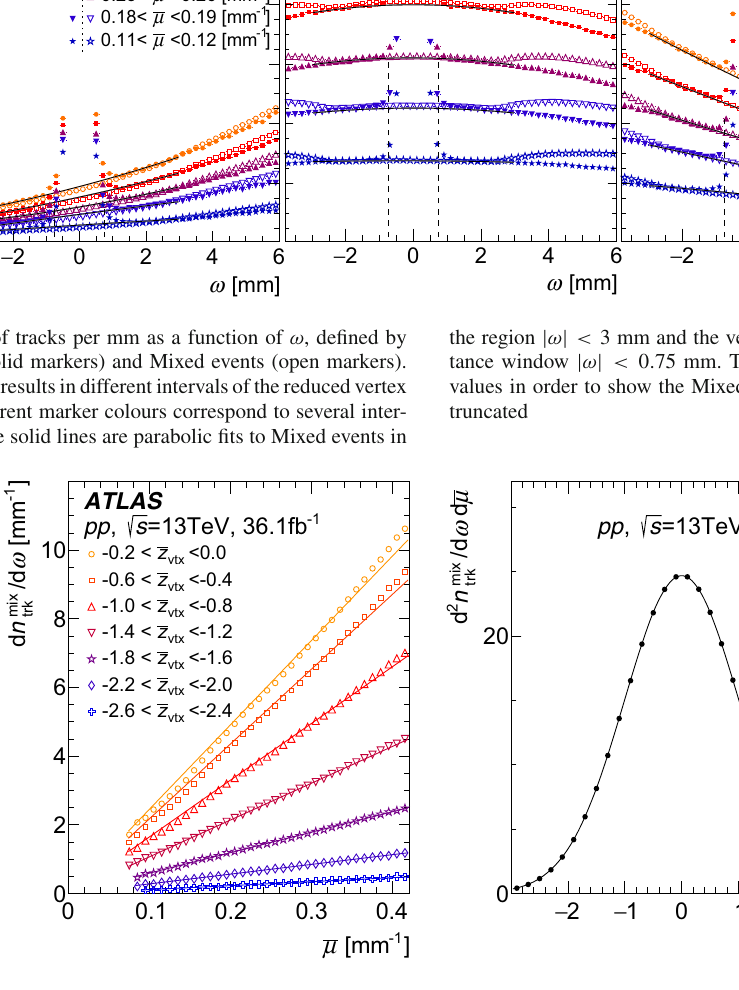
fits assuming scaling of track density with ¯ μ . Right: Slopes of the lines shown in the left panel as a function of ¯ z vtx fitted to a Gaussian